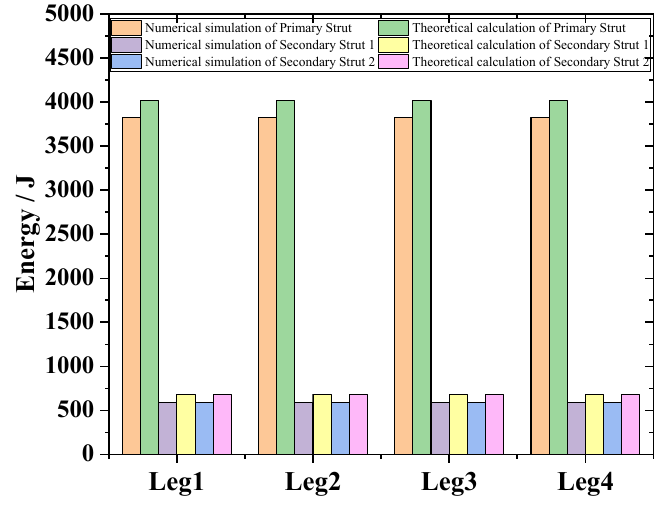
Figure 18. EA of 4 type landing.